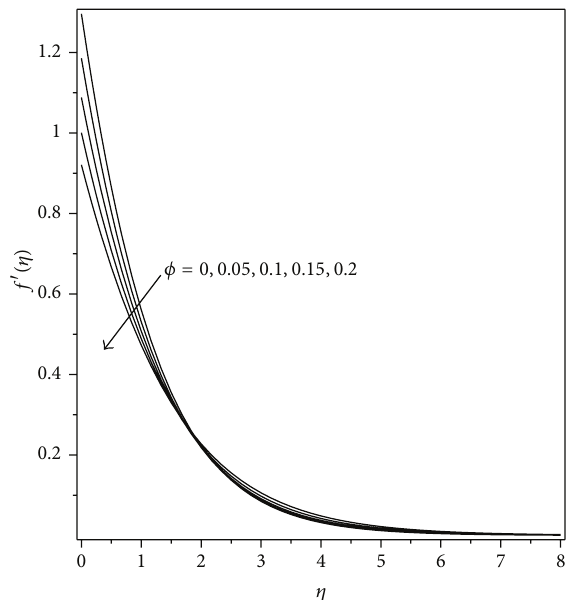
Figure 8: Dimensionless velocity profiles 𝑓 󸀠 (𝜂) for Al 2 O 3 nanopar- ticles with 𝑚 = 0 and various values of 𝜙 .